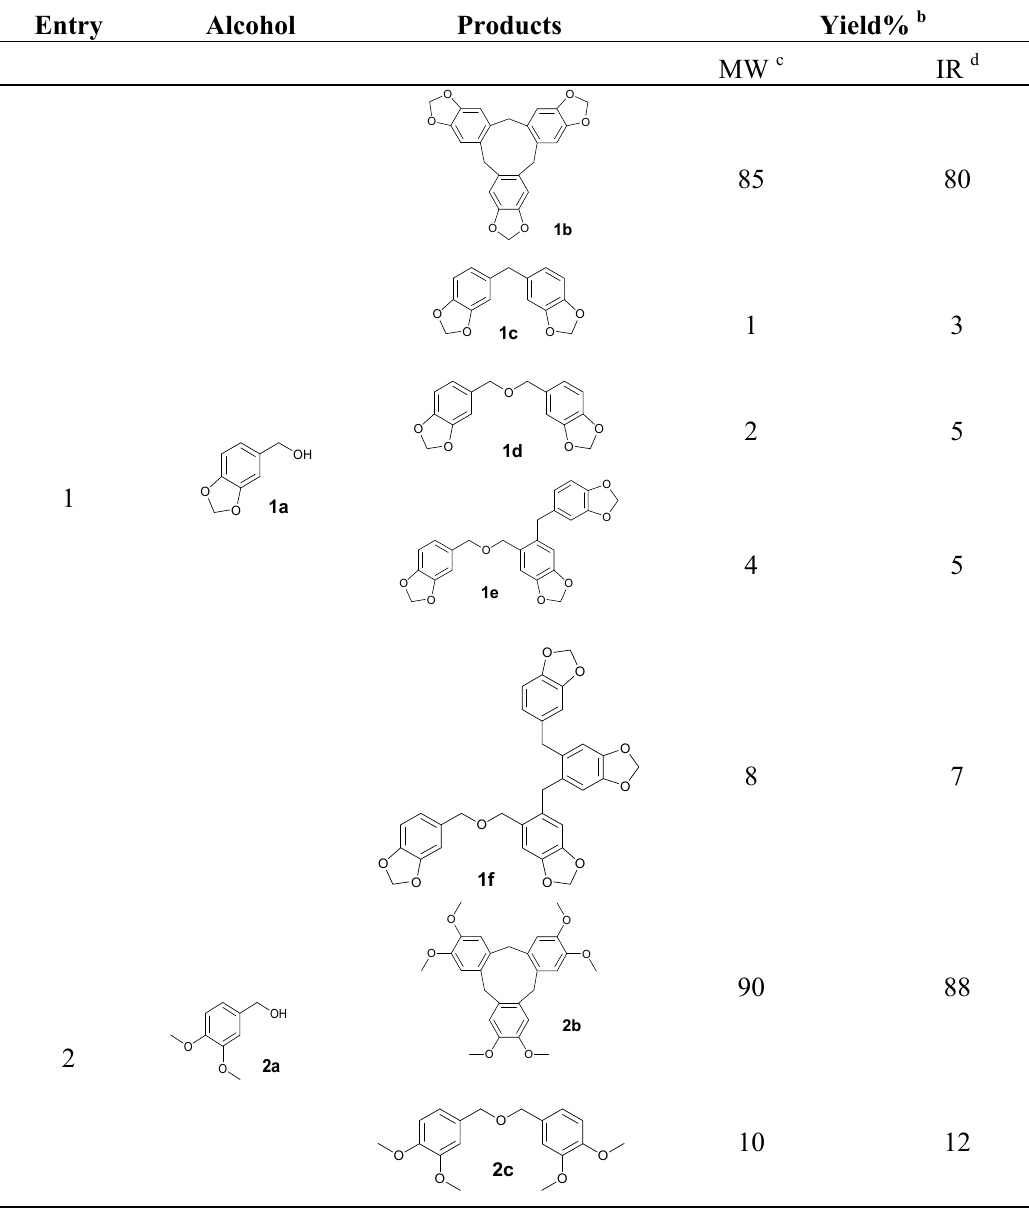
Table 1. Synthesis of cyclovertrylenes a